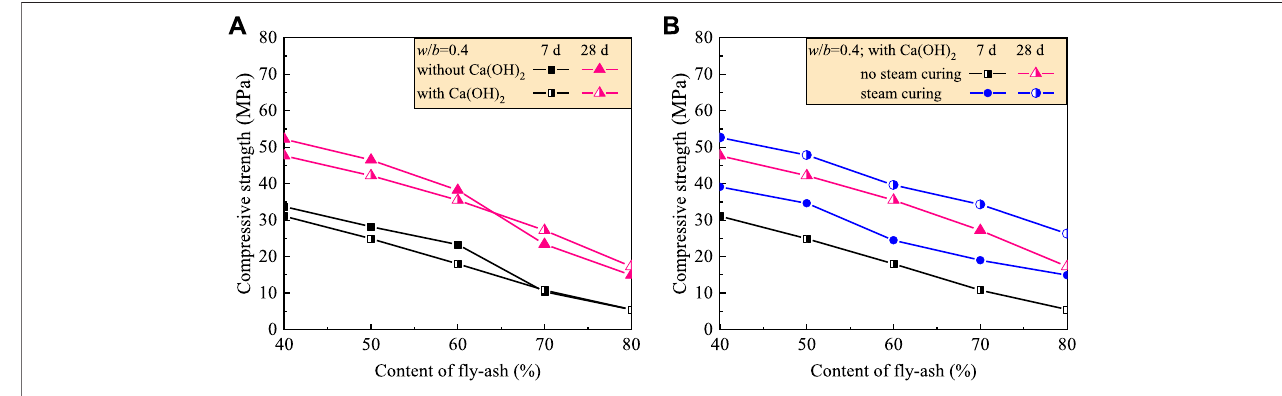
FIGURE 3 | Comparisons for the changes of compressive strength of test mortars: (A) with and without Ca(OH) 2 excitation; (B) cured in different conditions.